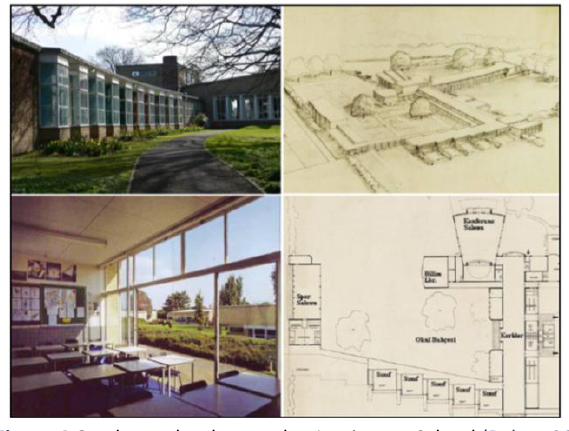
Figure 4 Outdoor school example - Impington School (Baker,